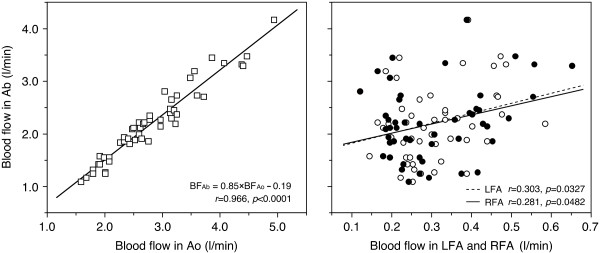
Relationship of blood flow in lower abdomen to the three arteries. BFAb was more strongly related to BFAo (r = 0.966, p < 0.0001) than to BFLFA or BFRFA (r = 0.303, p = 0.0327 in LFA; r = 0.281, p = 0.0482 in RFA) (n = 50). Ao, abdominal aorta; LFA, left femoral artery; RFA, right femoral artery; Ab, lower abdomen. Blood flow in the Ao, LFA, RFA and Ab is defined as BFAo, BFLFA, BFRFA, and BFAb respectively. Figure adapted from Osada et al. [13], reproduced with permission from The International Science Literature, Inc.